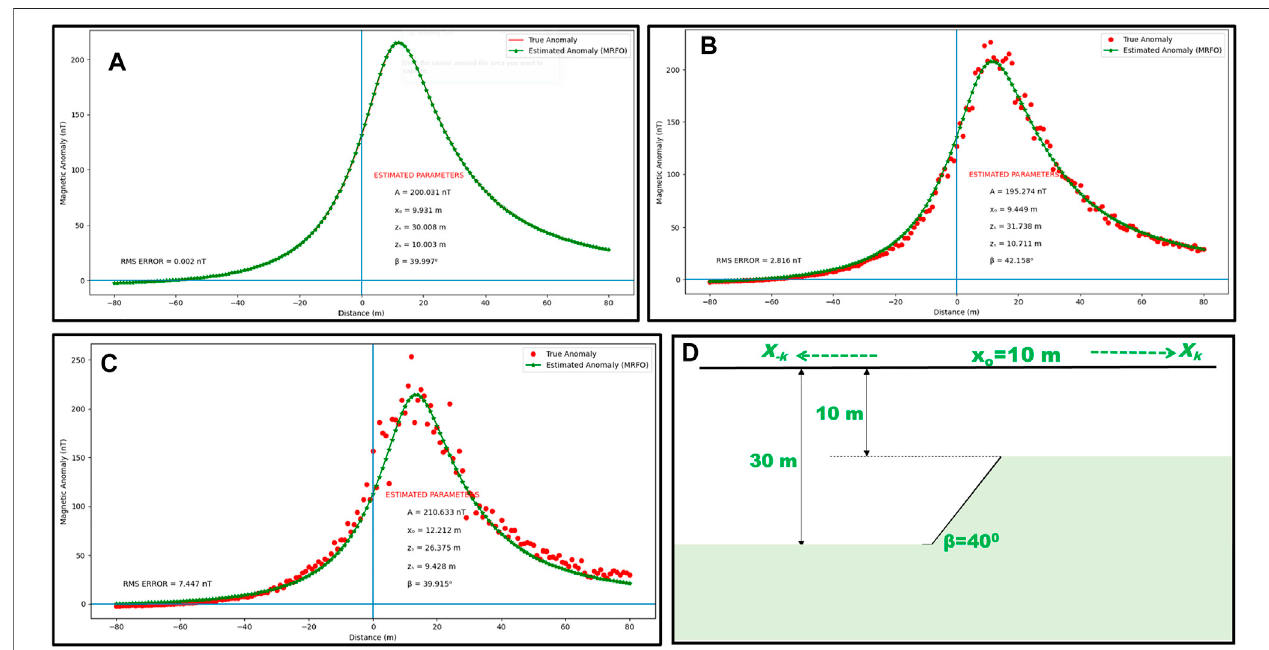
FIGURE5| Actualandestimatedanomalies(magnetic)ofasyntheticdippingfaultstructurewith (A) 0% (B) 5% (C) 10%GaussiannoiseusingMRFOalgorithm (D) Sketch of the fault model.